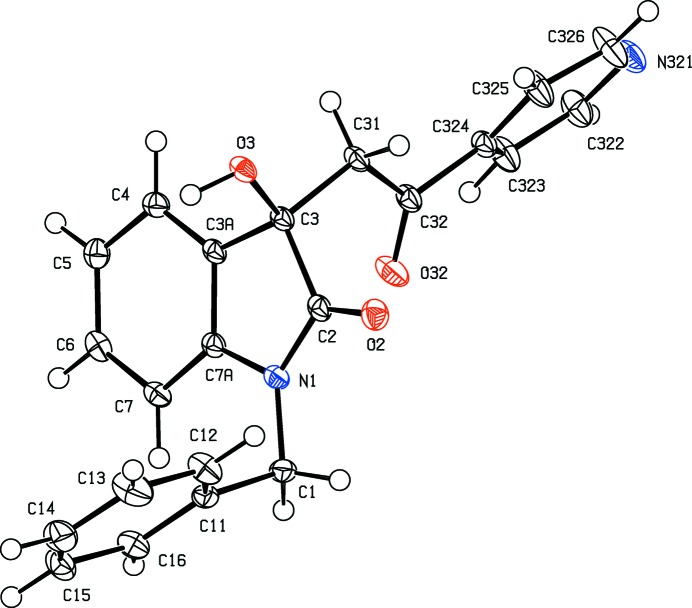
The mol­ecular structure of the R enanti­omer of com­pound (Ie), showing the atom-labelling scheme. Displacement ellipsoids are drawn at the 30% probability level.